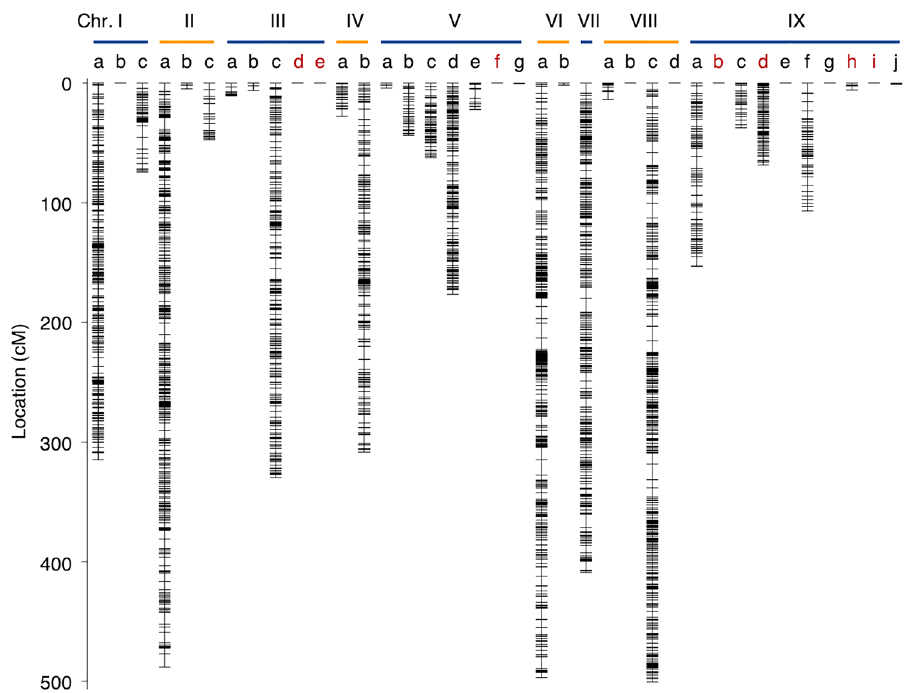
Figure 3. A high-density linkage map of the RILs of foxtail millet based on the flexible ddRAD-seq. Chromosome numbers correspond to S. italica reference genome, GCF_000263155.2, and the alphabets mean linkage group. The linkage group with red alphabets has been constructed using markers that the segregation distortion does not fit the expected ratio (1:1).